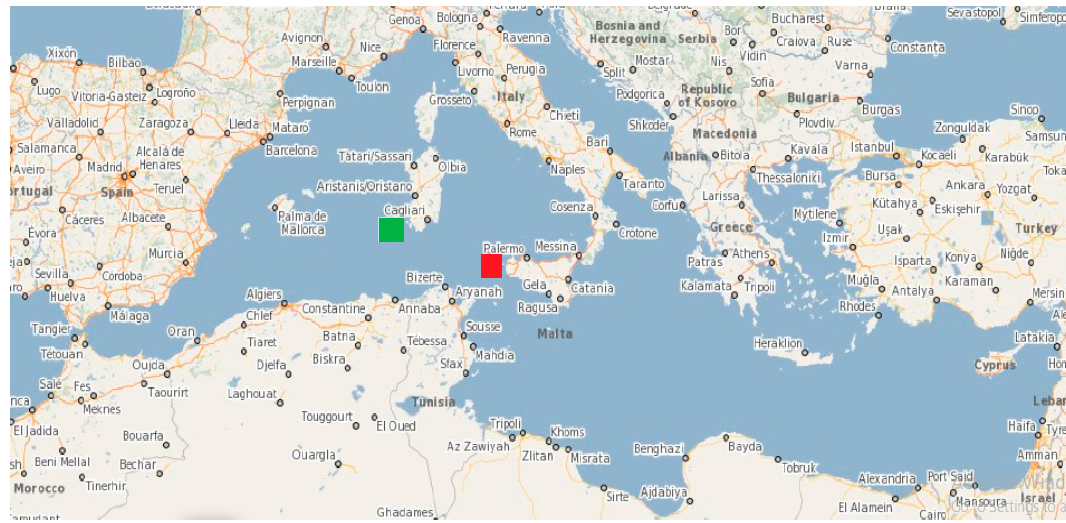
Figure 1. Two case studies near the Sicilian and Sardinia islands (with red and green boxes) in the Mediterranean Sea. Mediterranean